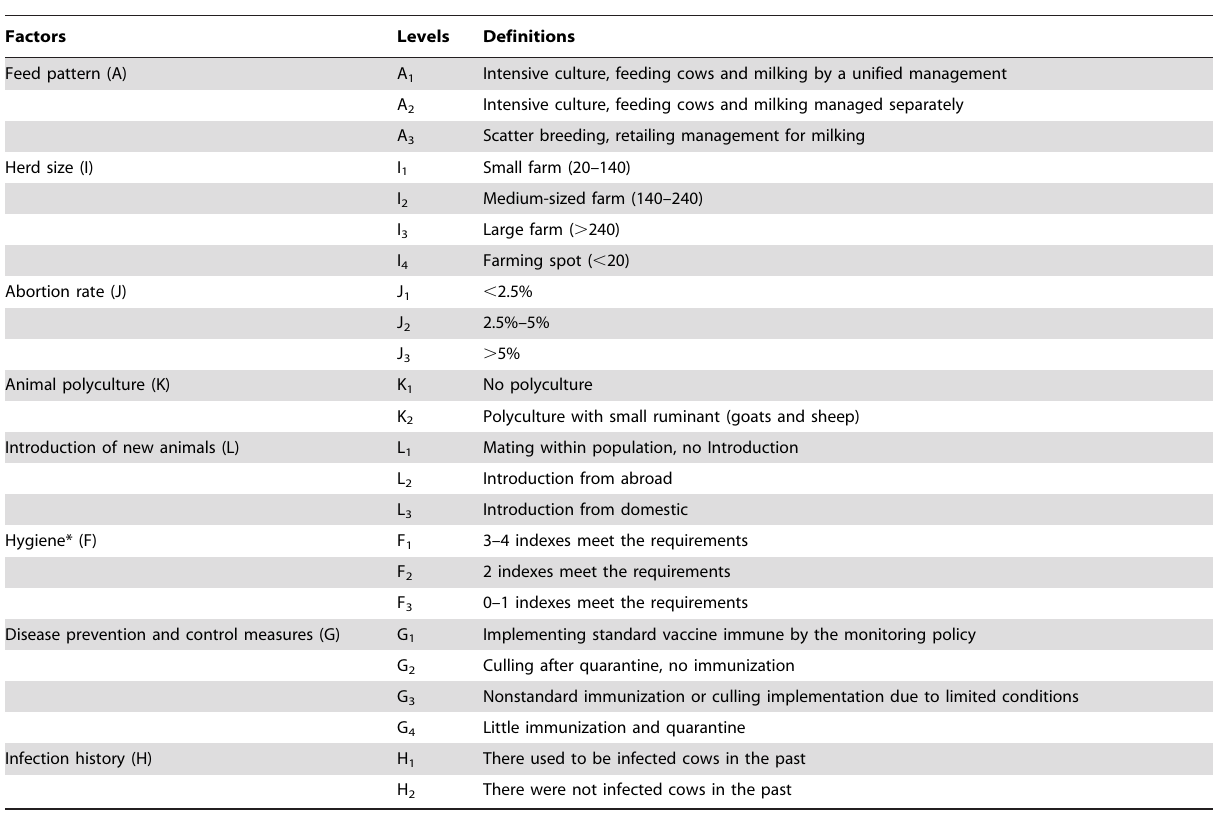
Table 2. Different levels and definitions of risk factors for Brucella contamination of raw milk.